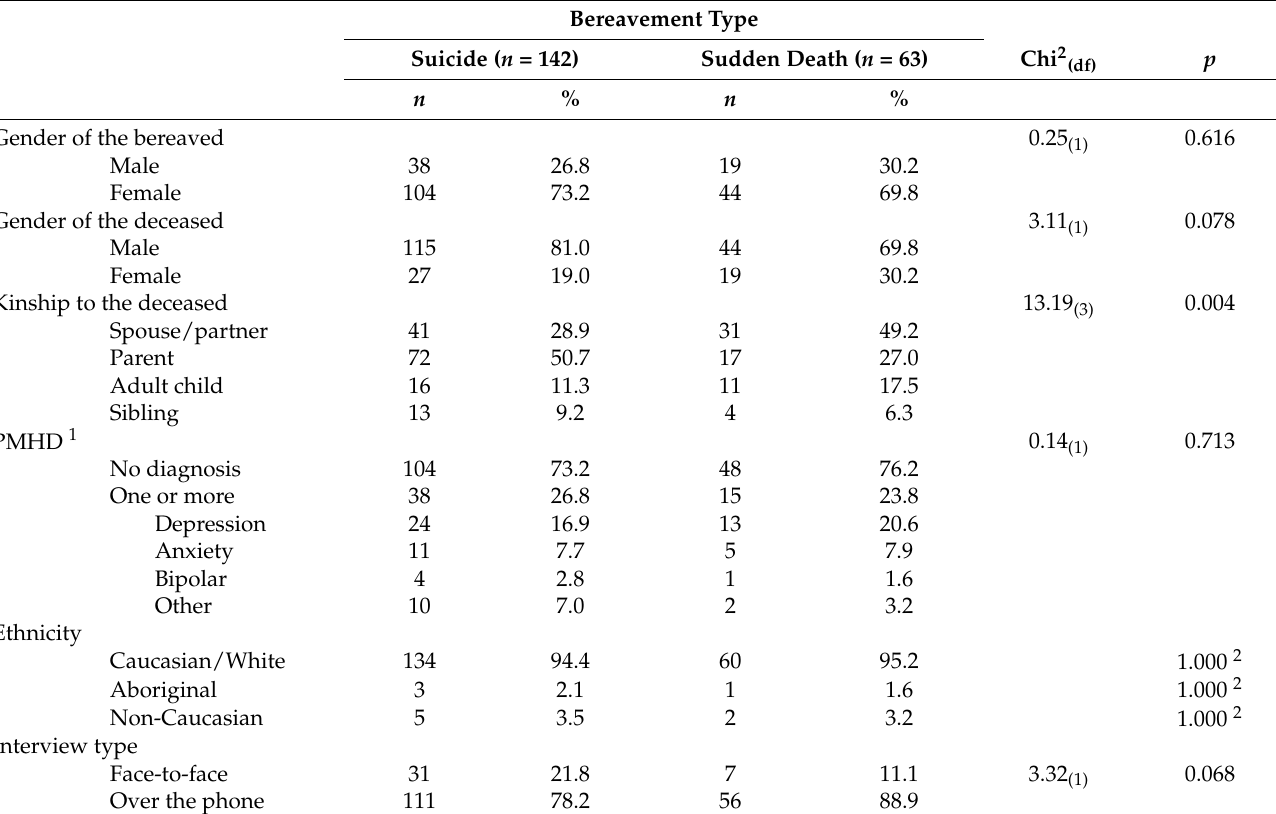
Table 1. Demographic characteristics of the sample, including gender of the